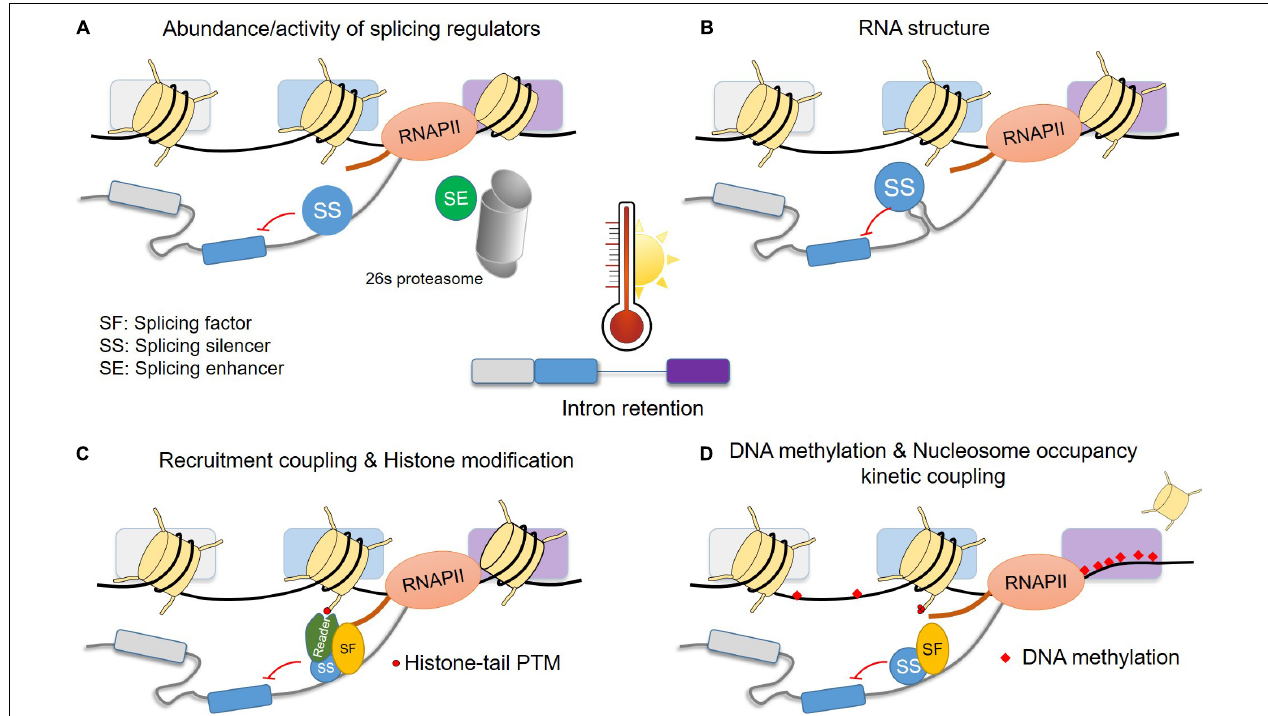
FIGURE 4 | Hypothetical model for the basis of intron retention under heat stress conditions. The model is depicted for IR but can apply for A5 (cid:48) SS and A3 (cid:48) SS as well. Possible effects of high temperatures on pre-mRNA splicing by (A) changes in the abundance of splicing regulators, (B) changes in RNA structure that can influence binding of splicing regulators, (C) recruitment of splicing regulators by histone modifications or direct interaction with RNAPII C-terminal domain, (D) heat stress induced changes in DNA methylation and nucleosome occupancy which can affect the RNAPII velocity and consequently binding of splicing regulators. Only few cases are depicted and more details can be found in see section “A Hypothetical Model for the Heat Stress Induced Intron Retention” in the main text. PTM: post-translational modification. Other abbreviations are explained in the figure.